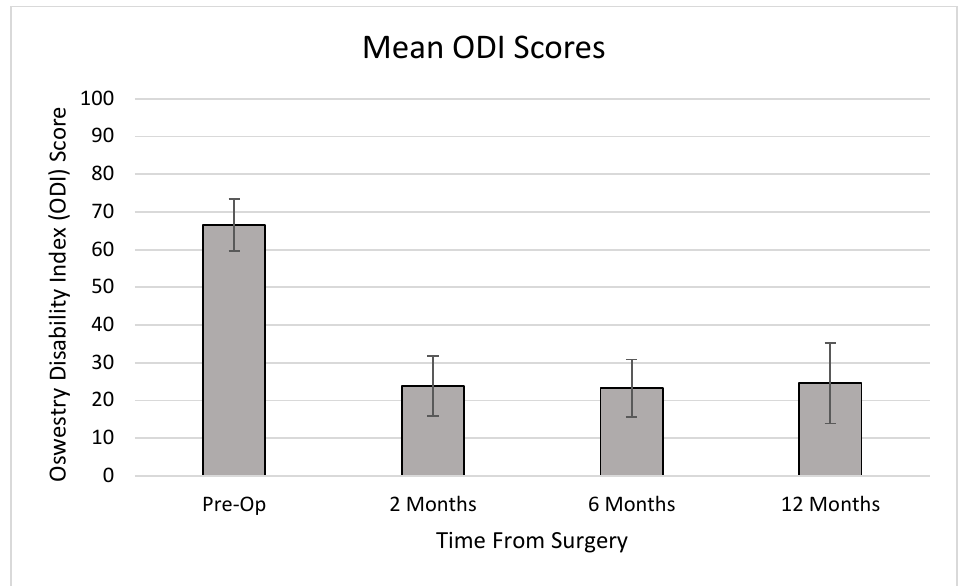
Figure 2 . Mean ODI Scores over time . Figure 2. Mean ODI Scores over